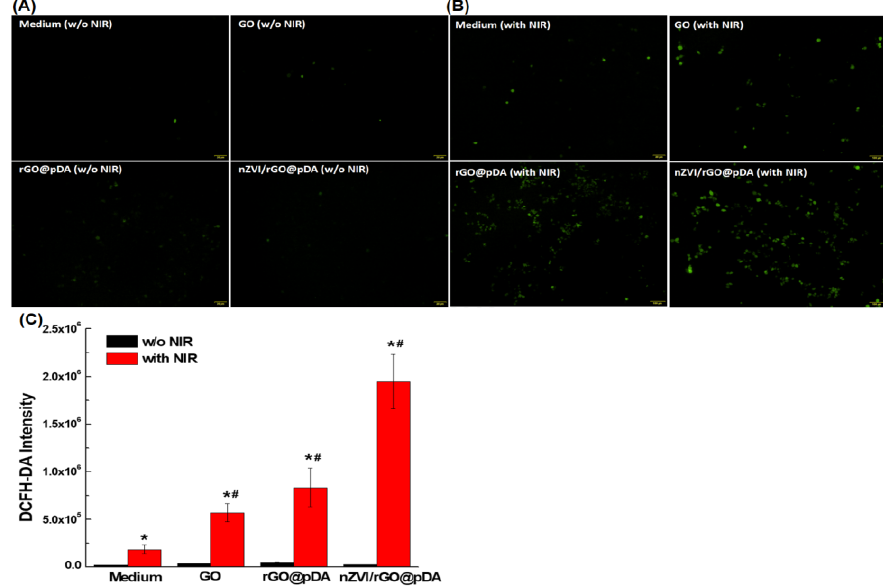
Figure 5. Photodynamic potential of nano zero-valent iron immobilized on the surface of reduced graphene oxide compared to modified with dopamine. Representative micrographs showing DCF fluorescence of MCF-7 cells after incubation with control solution, GO, rGO@pDA, nZVI/rGO@pDA ( A ) with and ( B ) without NIR irradiation. ( C ) Bar graph of quantitative analysis of reactive oxygen species formation (indicated by 2,7-dichlorofuorescin diacetate intensity) in MCF-7 cells following exposure to control solution, GO, rGO@pDA, or nZVI/rGO@pDA with/without NIR illumination.